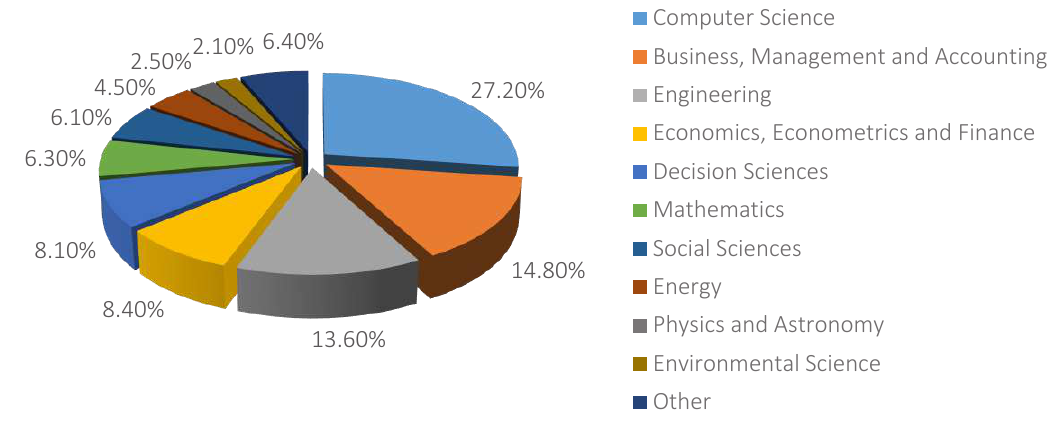
Figure 11. Structural analysis of “blockchain” AND “accounting” by subject areas